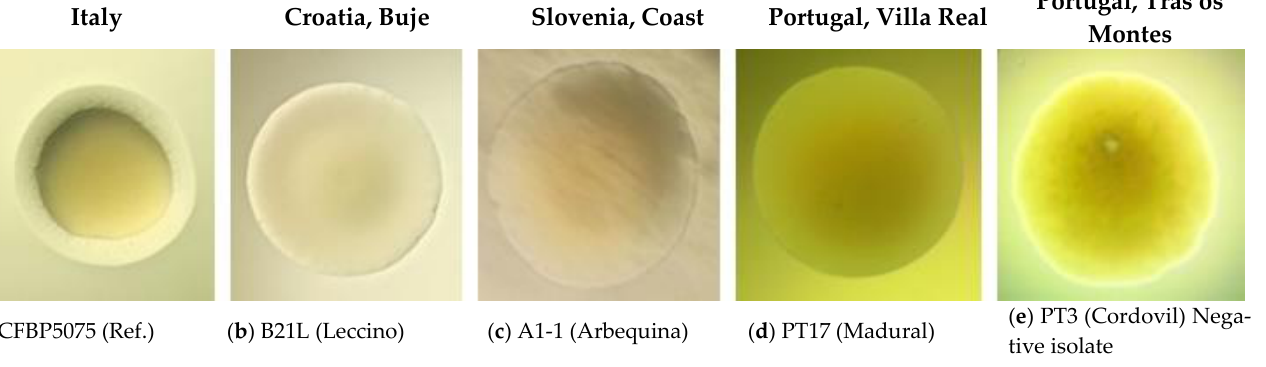
Figure 2. Colony morphology on King’s B (KB) solid growth media of Pseudomonas savastanoi pv. savastanoi reference strain CFBP5075 (Italy) and strains from Croatian, Slovenian and Portuguese infected olive cultivars: ( a ) CFBP5075 (reference); ( b ) B21 L (Leccino); ( c ) A1-1 (Arbequina); ( d ) PT17 (Madural); ( e ) PT3 (Cordovil). Pss colonies presented in figure were tested using the LOPAT scheme, with the following results: levan production: ( a ) negative, ( b ) negative, ( c ) negative, ( d ) negative, ( e ) negative; oxidase activity: ( a ) negative, ( b ) negative, ( c ) delayed positive, ( d ) negative, ( e ) positive; pectolytic activity: ( a ) negative, ( b ) negative, ( c ) negative, ( d ) negative, ( e ) positive; arginine dihy- drolase activity — (a) negative, ( b ) negative, ( c ) negative, ( d ) negative, ( e ) negative; tobacco hyper- sensitivity reaction (HR): ( a ) positive, ( b ) positive, ( c ) positive, ( d ) positive, ( e ) not tested. In the biochemical characterisation, 34 out of 88 (38.6%) isolates tested negative for oxidase, pectolytic activity and the presence of arginine dihydrolase (Tables 3 and S2). Based on these results, these isolates were classified as group Ib, as expected [29]. The exceptions were Slovenian isolates, which were generally delayed positive for oxidase ac- tivity. Only four Slovenian isolates (i.e., 13.3% of the total Slovenian strains coded as L6- 2, L5-1, F4-2 and At2-4) were negative for oxidase activity. Most Croatian isolates did not produce fluorescent pigment under UV light when grown on KB solid media. Conversely, all isolates from Slovenia and Portugal tested positive for the in vitro production of fluo- rescent pigments when grown on solid KB medium. Table 3. LOPAT characteristics of P. savastanoi pv. savastanoi isolates from Croatian, Slovenian and Portuguese olive orchards. Characteristic